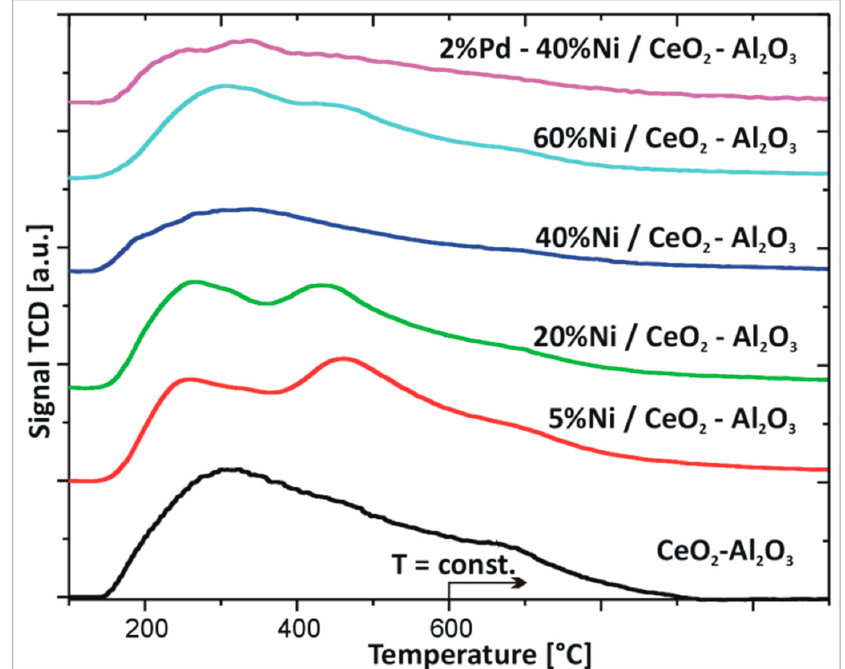
Figure 7. TPD–NH 3 profile of the binary oxide and monometallic catalysts after calcination in air for 4 h at 400 °C.